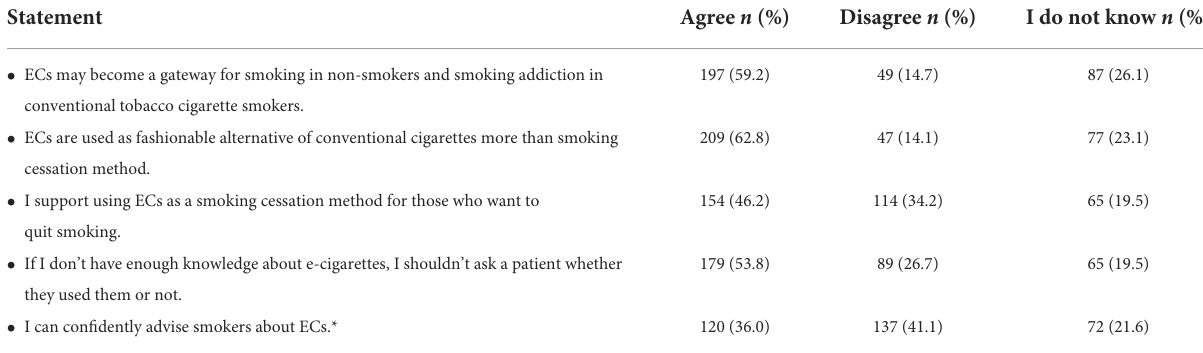
TABLE 5 Perception and attitude of health care students toward